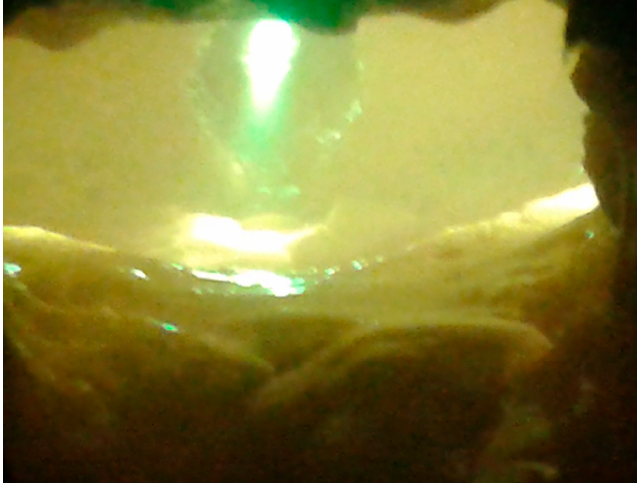
Figure 1. Plasma reactor chamber during operation. In the middle is a visible plasma torch during operation. The picture taken through a light filter, with a temperature in the reactor about 1450 °C.